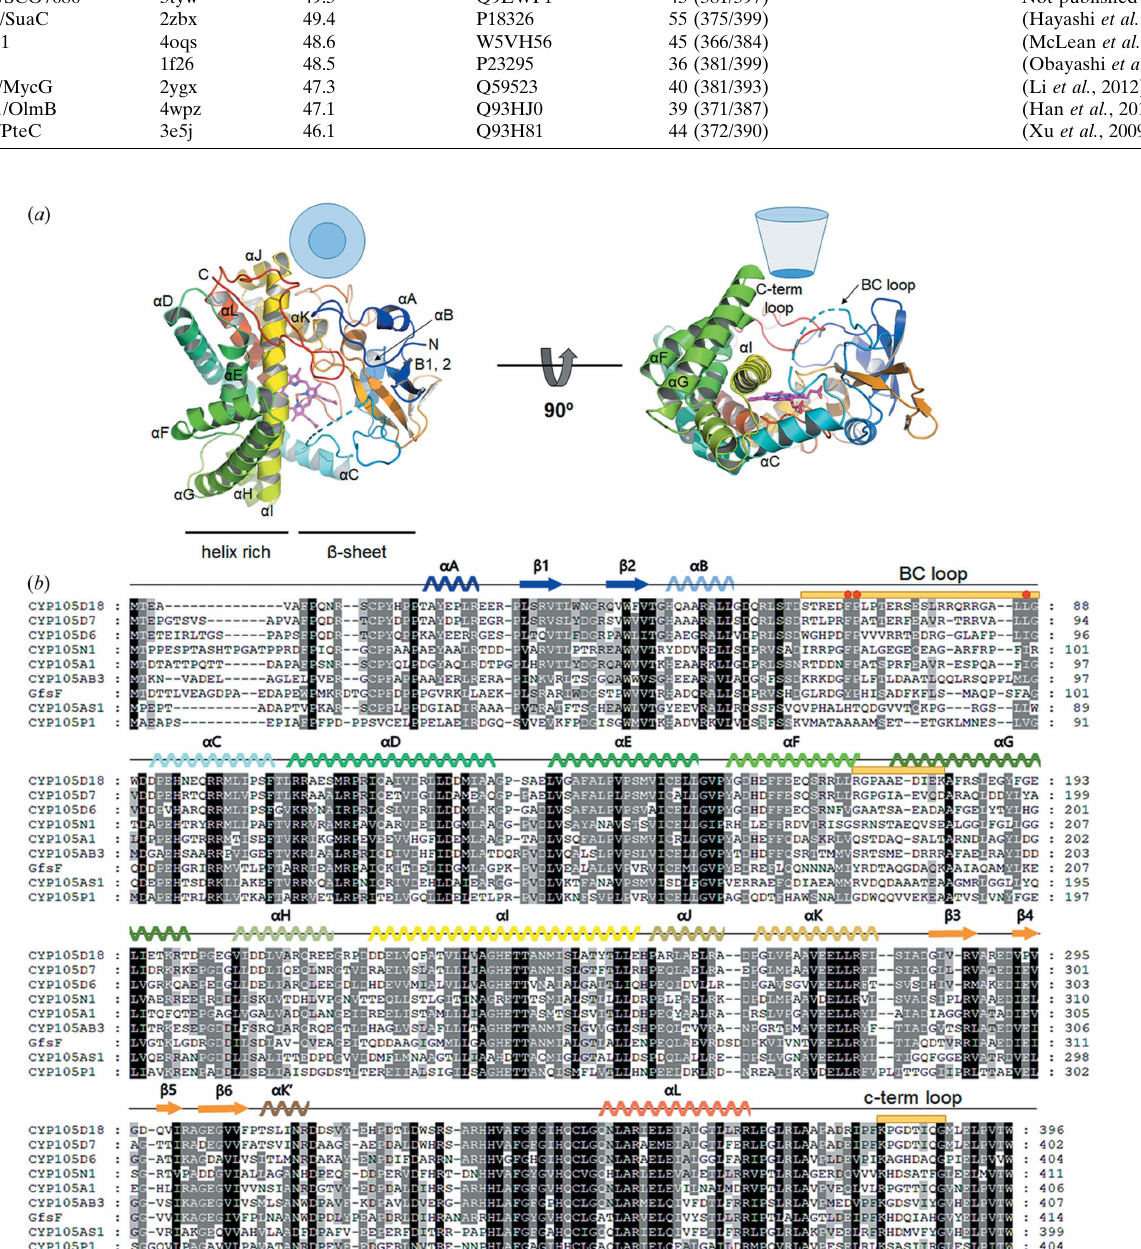
Figure 5 ( a ) Ribbon diagram of the CYP105D18 structure. Rainbow coloring from blue to red indicates the N- to C-terminal positions of residues in the model. The right panel is rotated by 90 (cid:5) relative to the left panel, such that the side of the substrate-binding funnel in the right panel orients toward the reader in the left panel. The nomenclature of the secondary helices and (cid:2) -sheets was chosen from previous studies. ( b ) Multiple sequence alignment with other homologous CYPs. CYP105D18 from S. laurentii , CYP105D7 and CYP105D6/PteD from Streptomyces sp. , CYP105D6 from S. avermitilis , CYP105N1 from S. coelicolor , CYP105A1 from S. griseolus , CYP105AB3 from Nonomuraea recticatena , GfsF from S. graminofaciens , CYP105AS1 from Amycolatopsis orientalis , and CYP105P1 from S. avermitilis . Secondary structural elements are shown above the aligned sequences and colored according to the scheme in Fig. 5( a ). Regions for the active site are marked with orange sticks, and conserved residues at the B/C loop and turn of (cid:3) F– (cid:3) G are marked by red